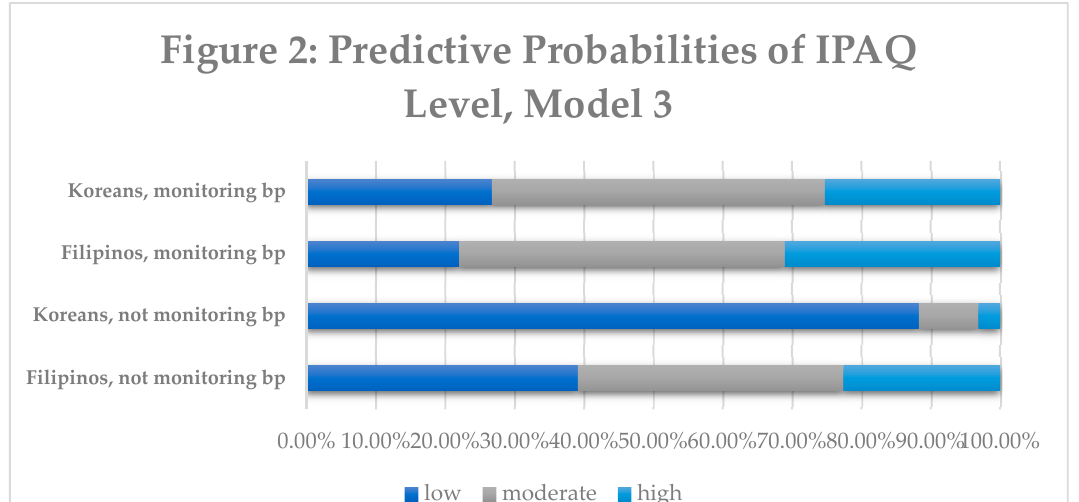
Figure 1. There are four predictive probabilities presented based on ethnicity and high blood pressure status. Physical activity level (%) is represented in the graph; green represents low activity group, blue represents moderate activity group and yellow represents the high activity group. Figure 2: Predictive Probabilities of IPAQ